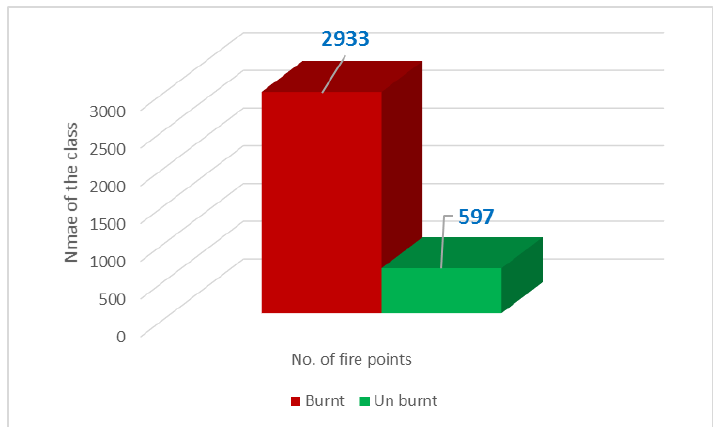
Figure 6. Number of fires in burnt classes of